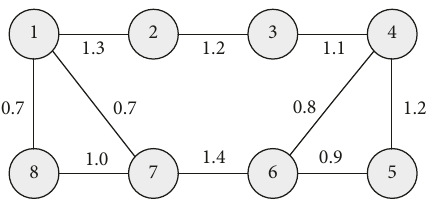
Figure 1: Communication topology G